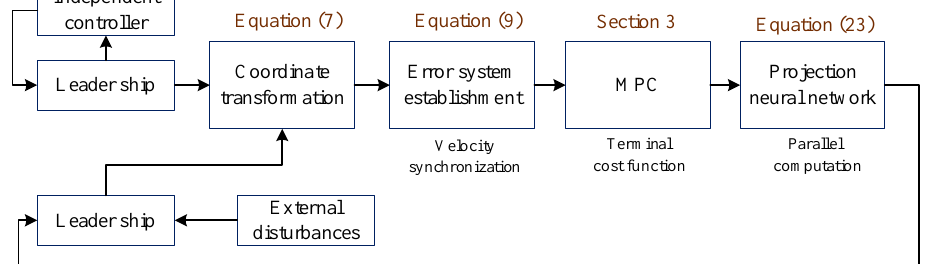
Figure 1. The design block diagram of the presented synchronization controller.